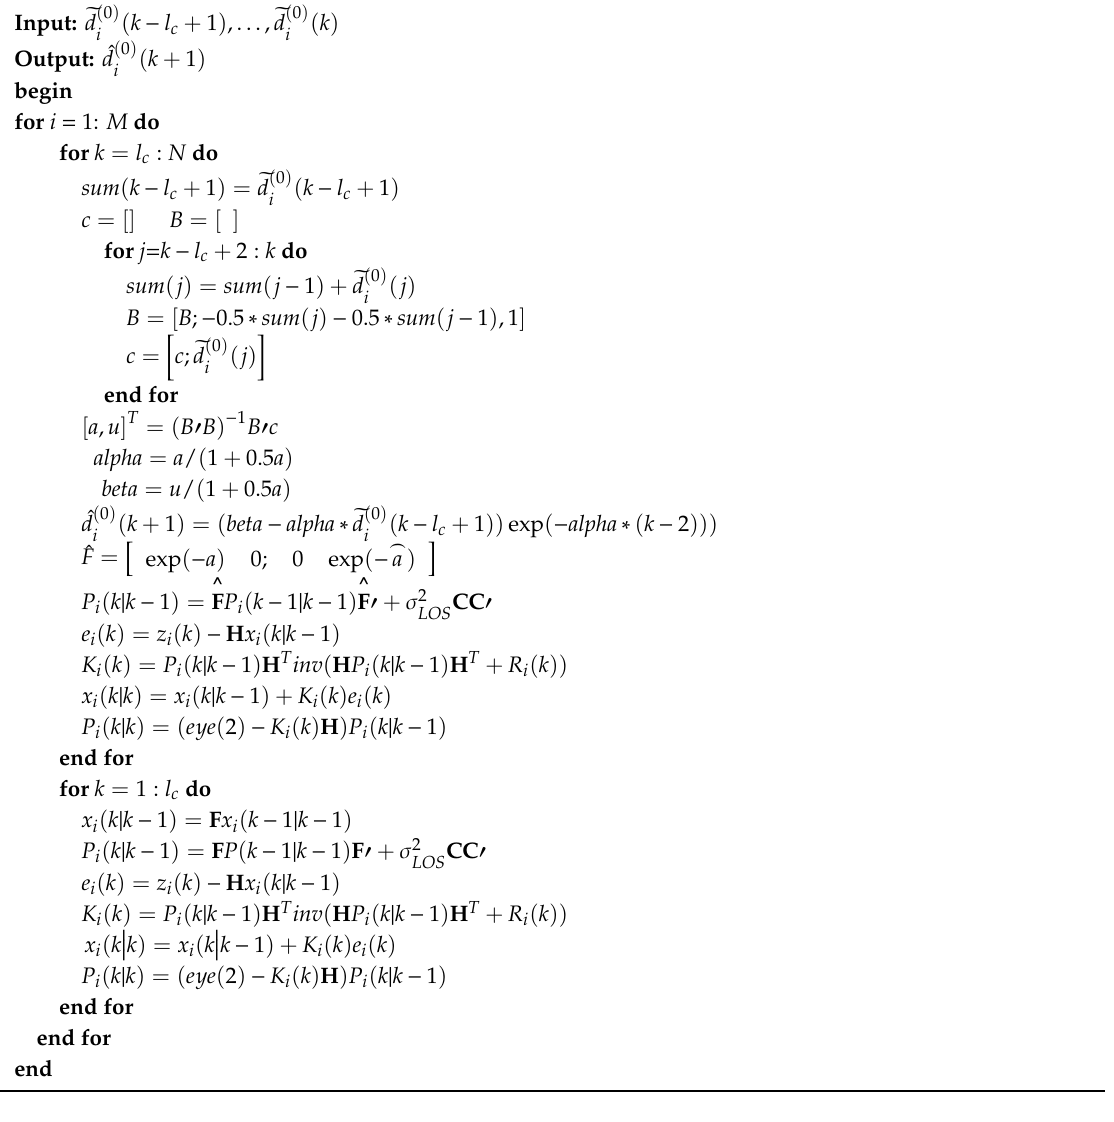
Algorithm 1. The pre-processing for the measurements based on grey Kalman filter